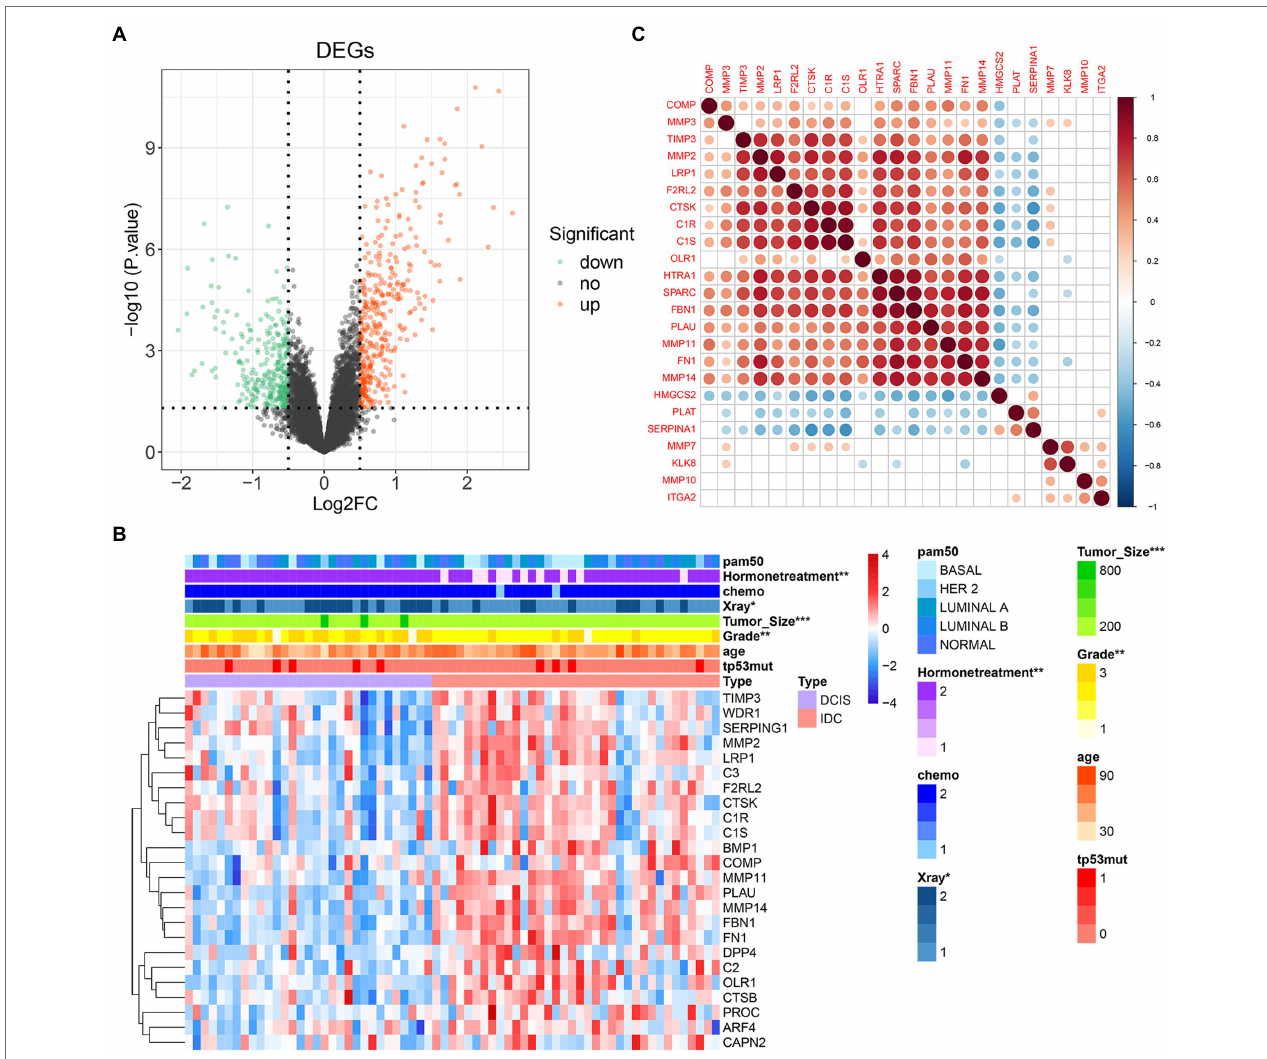
FIGURE 2 | COAGULATION-related genes expression and correlation analysis. (A) Volcano map reveals the distribution of downregulated and upregulated DECGs. X -axis: fold change; Y -axis: − log10 p -value. (B) Heat map shows the expression of differentially expressed COAGULATION-related genes between DCIS and IDC samples. (C) Pearson correlation of these differentially expressed COAGULATION-related genes. * p < 0.05, ** p < 0.01, and *** p